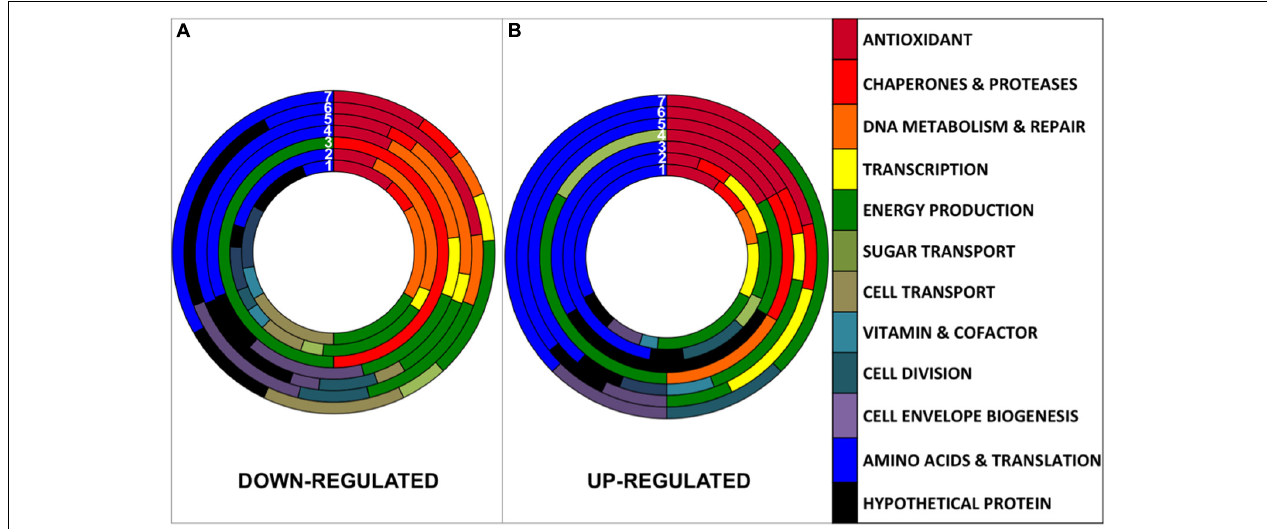
FIGURE 3 | Comparison of the distribution of down-regulated (A) and up-regulated (B) proteins between the different conditions numbered from 1 to 7. (1) Artificial UVB (49 proteins), (2) Natural Full Sun (48 proteins), (3) Natural PAR (8 proteins), (4) Natural PAR+UVA (19 proteins), (5) Natural UVA+UVB (47 proteins), (6) Natural UVB (27 proteins), and (7) Natural UVA (29